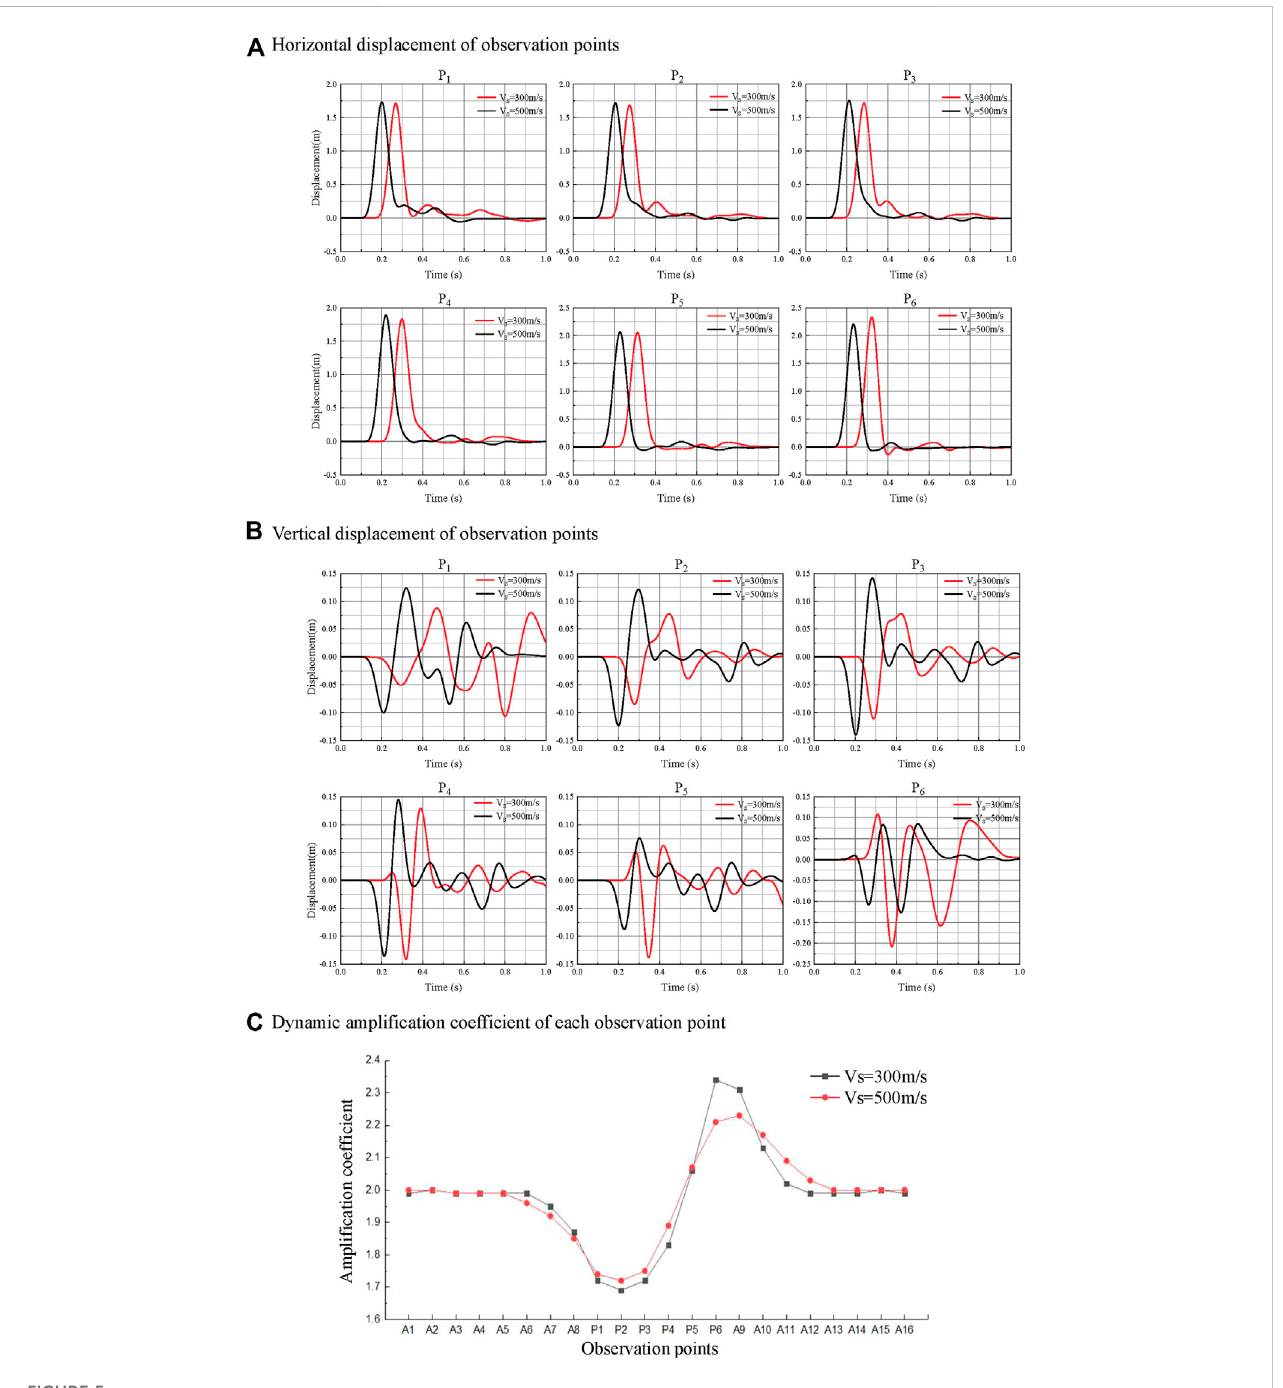
FIGURE 5 Calculation result of the fi nite element model of the 2D slope